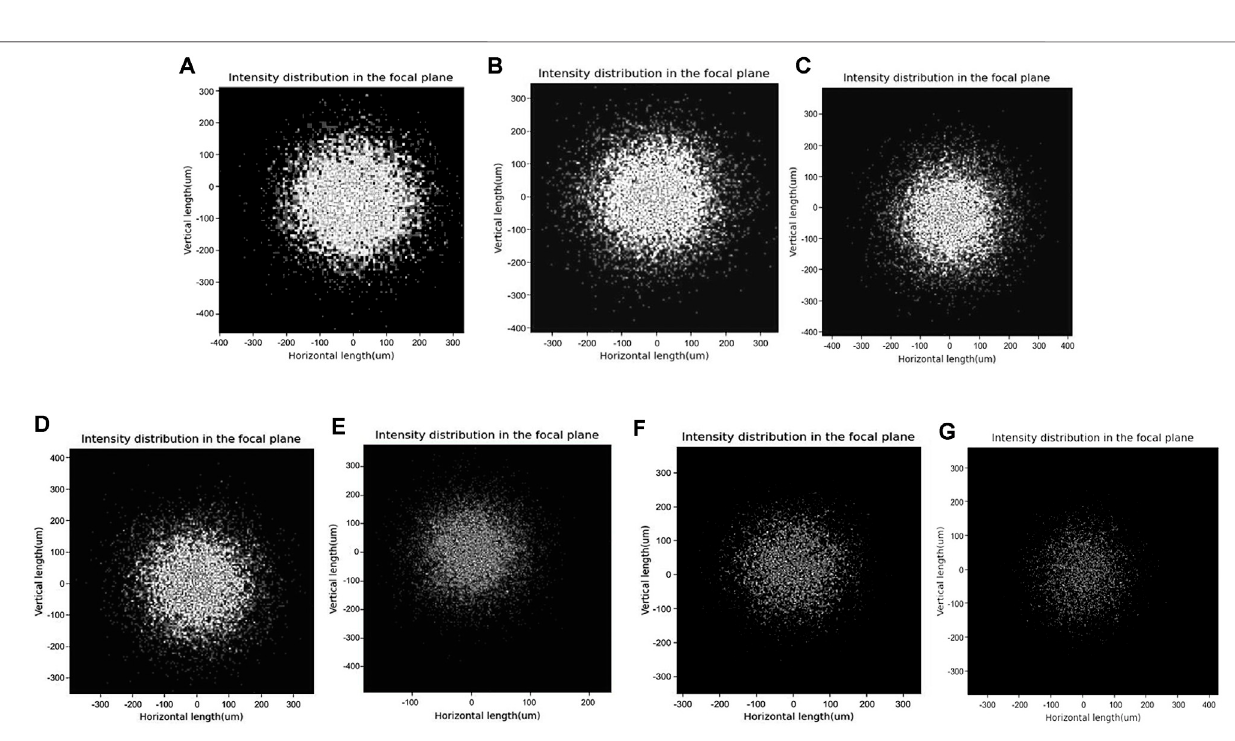
Frontiers in Physics |